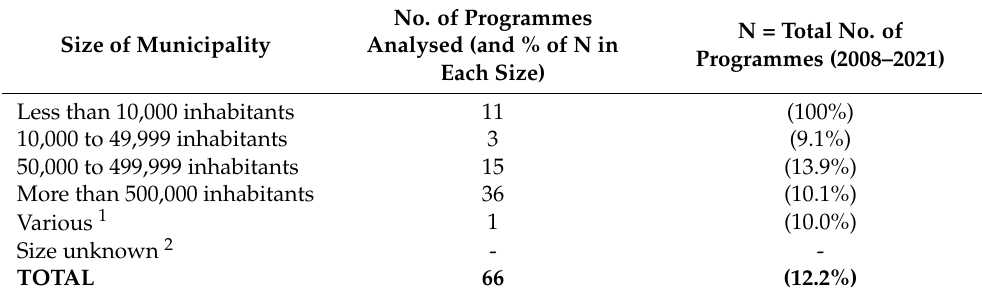
Table 1. Distribution of interviews in “wise words” segment by size of municipality.